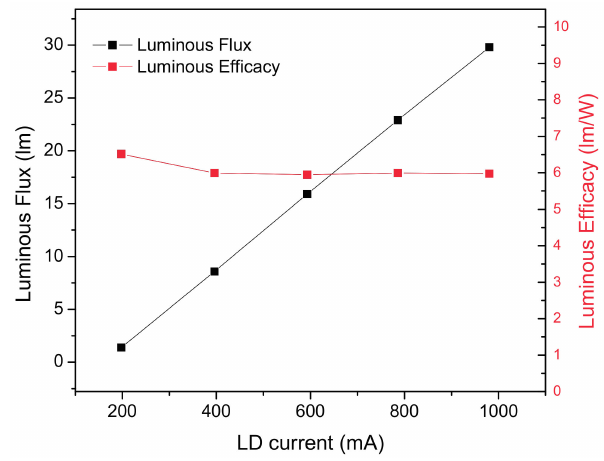
Figure 14. Luminous flux and luminous efficacy of the transmission LARP